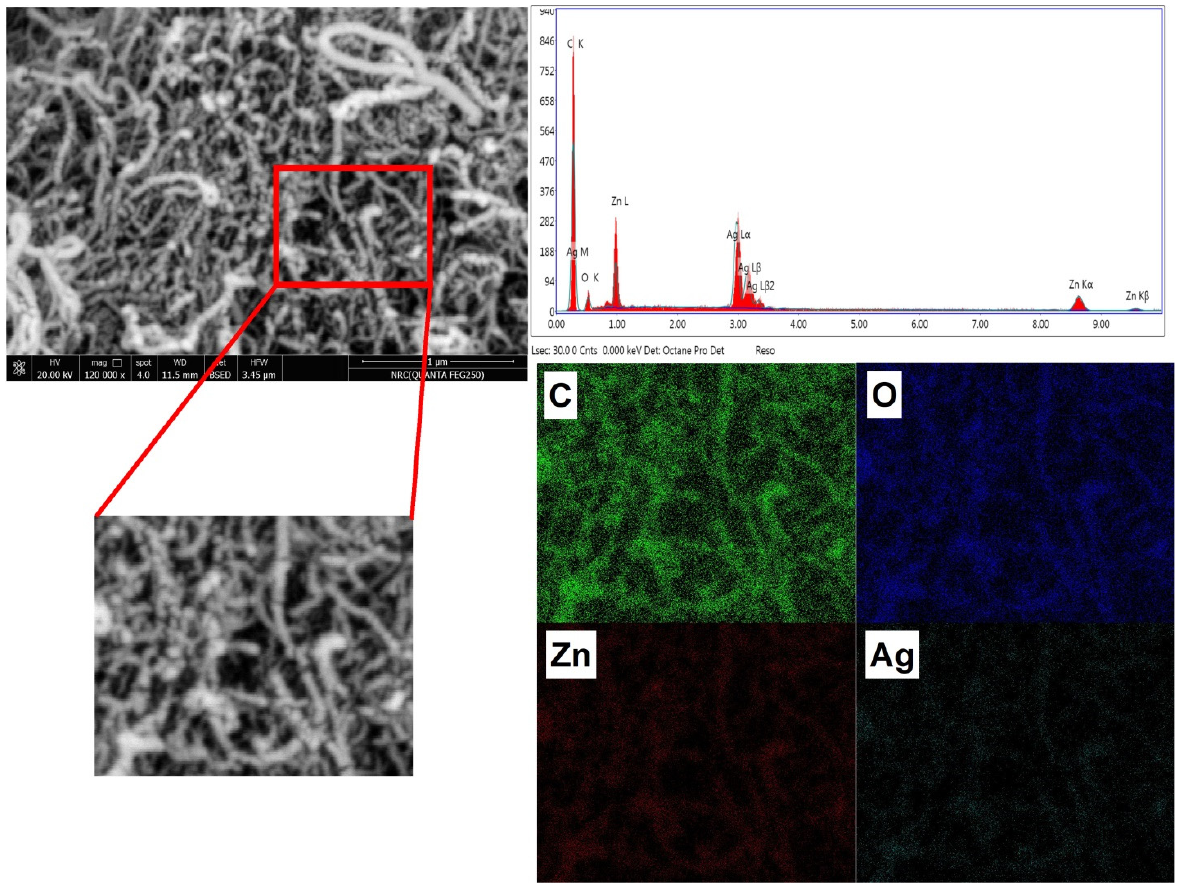
Figure 4. SEM image. EDX analysis and mapping of Ag-doped ZnO/MWCNTs nanocomposite.